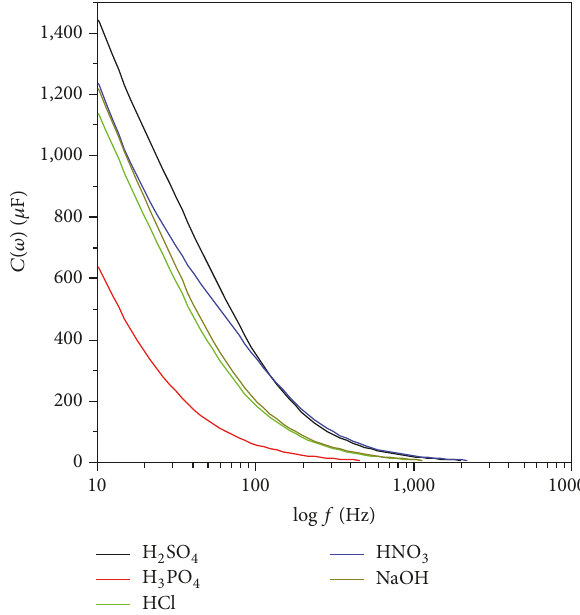
Figure 5: Frequency response of capacitance of a Ti/RuO 2 electrode (versus RHE) in different solutions at 25 ∘